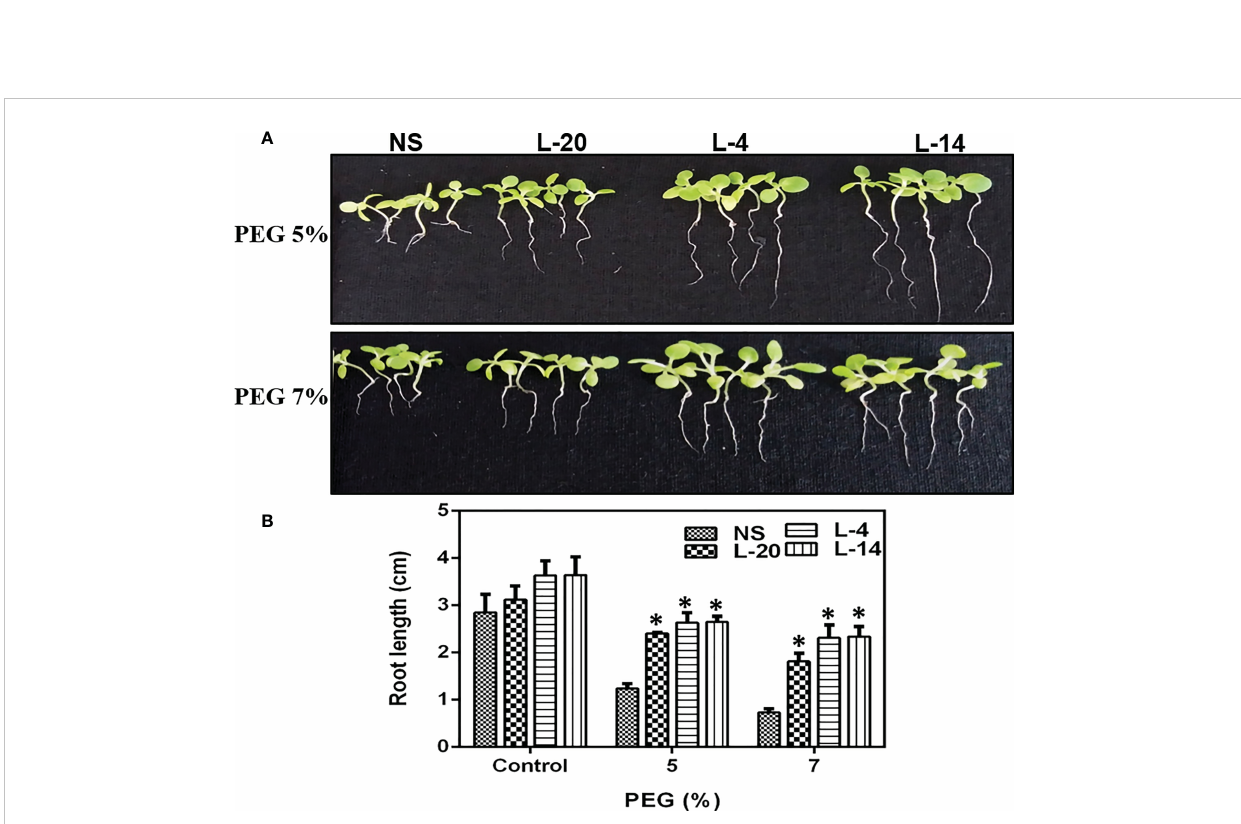
FIGURE 6 Analysis of enhanced PEG endurance in transgenic lines of VaDJI ; (A) under 5% PEG, and 7% PEG. Photographs of NS and transgenic lines were taken after drought stress for 12 days of growth., (B) Difference observed in the seedlings root growth in the presence of 5% and 7% PEG 6000. Data were represented as mean ± SE. Statistical signi fi cance was tested using one-way analysis of variance (ANOVA) and *(single asterisk) indicates p ≤